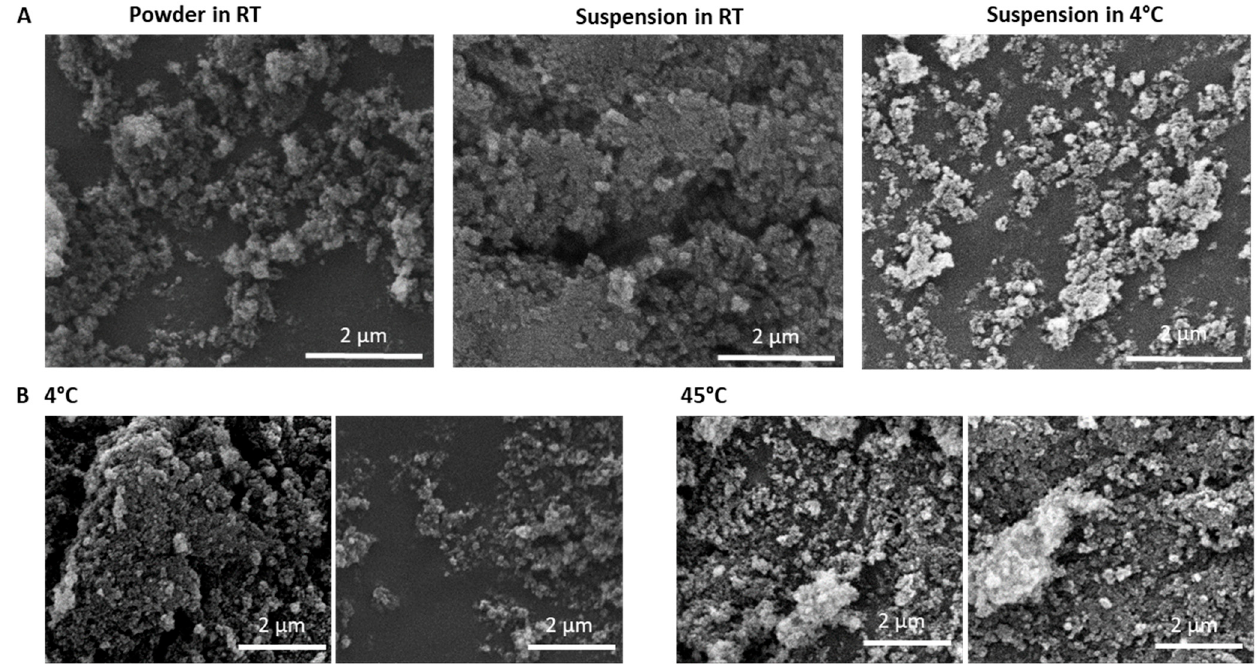
Figure 7. Stability of Calcium carbonate-silicate in different storage conditions and temperature. ( A ) SEM images of samples that were stored as a powder in room temperature; suspension in room temperature; or as a suspension in 2–8 °C . ( B ) SEM images of synthesized in 4 °C or in 45 °C.